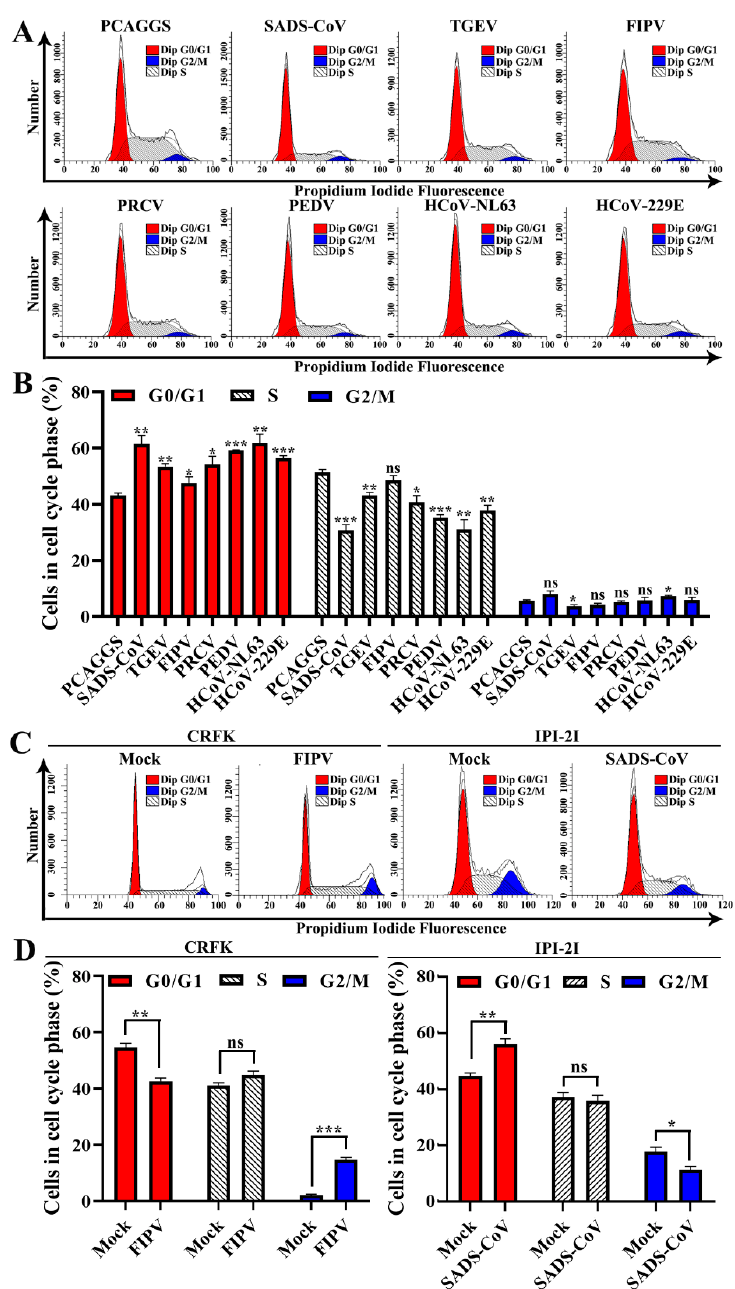
Figure 8. E ff ects of α -CoV nsp1 on the HEK-293T cell cycle. ( A ) 293T cells transfected with an empty vector or α -CoVs nsp1 vector for 24 h were fixed, stained with PI in the presence of RNase A, and analyzed by flow cytometry to determine the DNA content and the cell population distributions in the various cell cycle phases. ( B ) The statistical result is relative to figure A. ( C ) CRFK cells infected 0.1 MOI FIPV for 12 h or IPI-2I cells infected 0.1 MOI SADS-CoV for 24 h were fixed, stained with PI in the presence of RNase A, and analyzed by flow cytometry to determine the DNA content and the cell population distributions in the various cell cycle phases. ( D ) The statistical result is relative to figure C. Data are represented as means ± SEM ( n = 3). The values were calculated and differences were considered for p < 0.05 (Kruskal Wallis test). Ns: Not significant; *, p < 0.05; **, p < 0.01; and ***, p < 0.001.